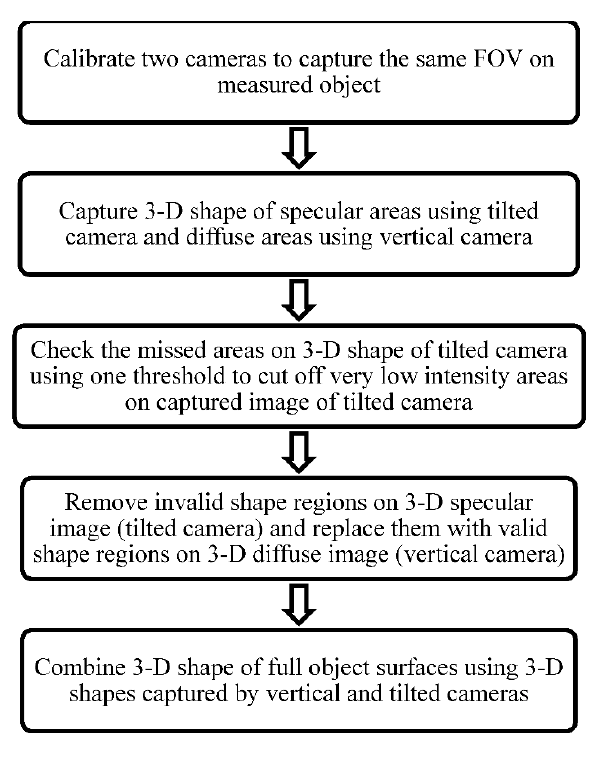
Figure 4. Flowchart of the proposed measuring technique.